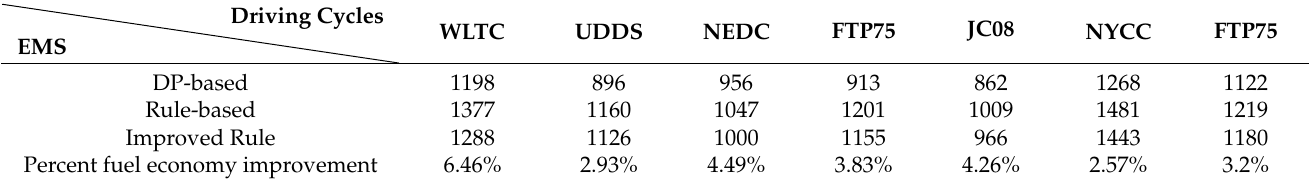
Table 3. The equivalent 100 km hydrogen consumption (g/100 km) under different driving